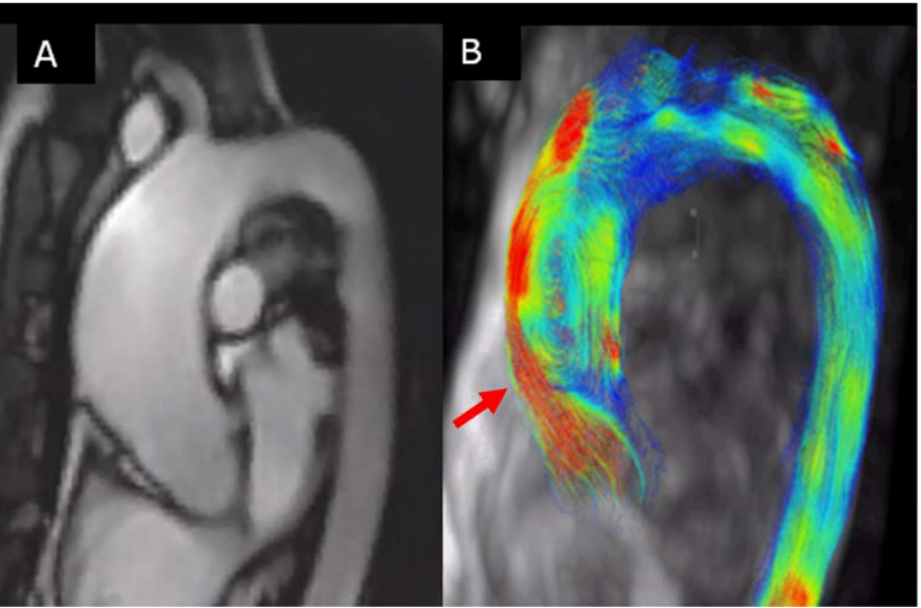
Figure 8. ( A ) Thoracic aorta by CMR images of BAV with RC − LC fusion; ( B ) 4D ‐ MRI dimensional flow. Note that flow impinges on the outer curvature of the proximal ascending aorta (arrows), including the root (red arrow).